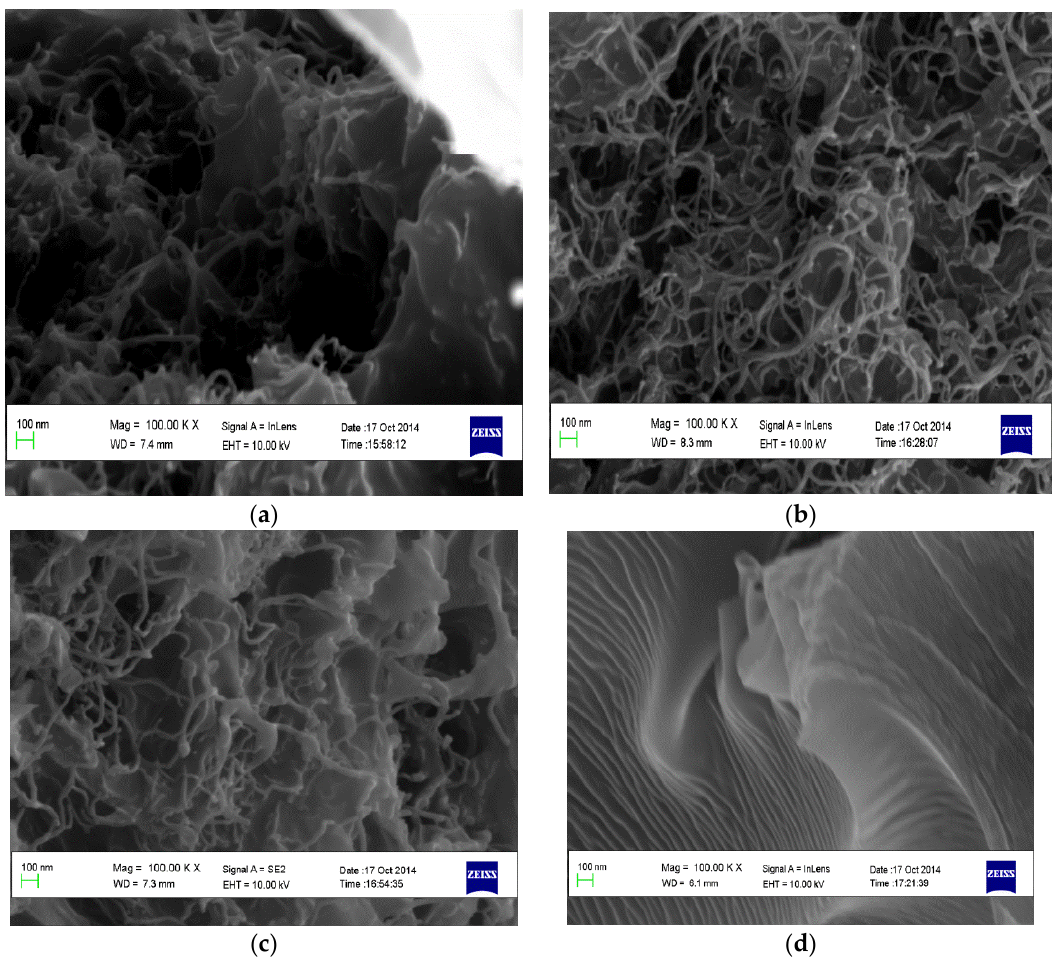
Figure 5. SEM micrographs of the cross-sectional view of the membranes showing their morphologies ( a ) M1; ( b ) M2; ( c ) M3; and ( d ) M4.